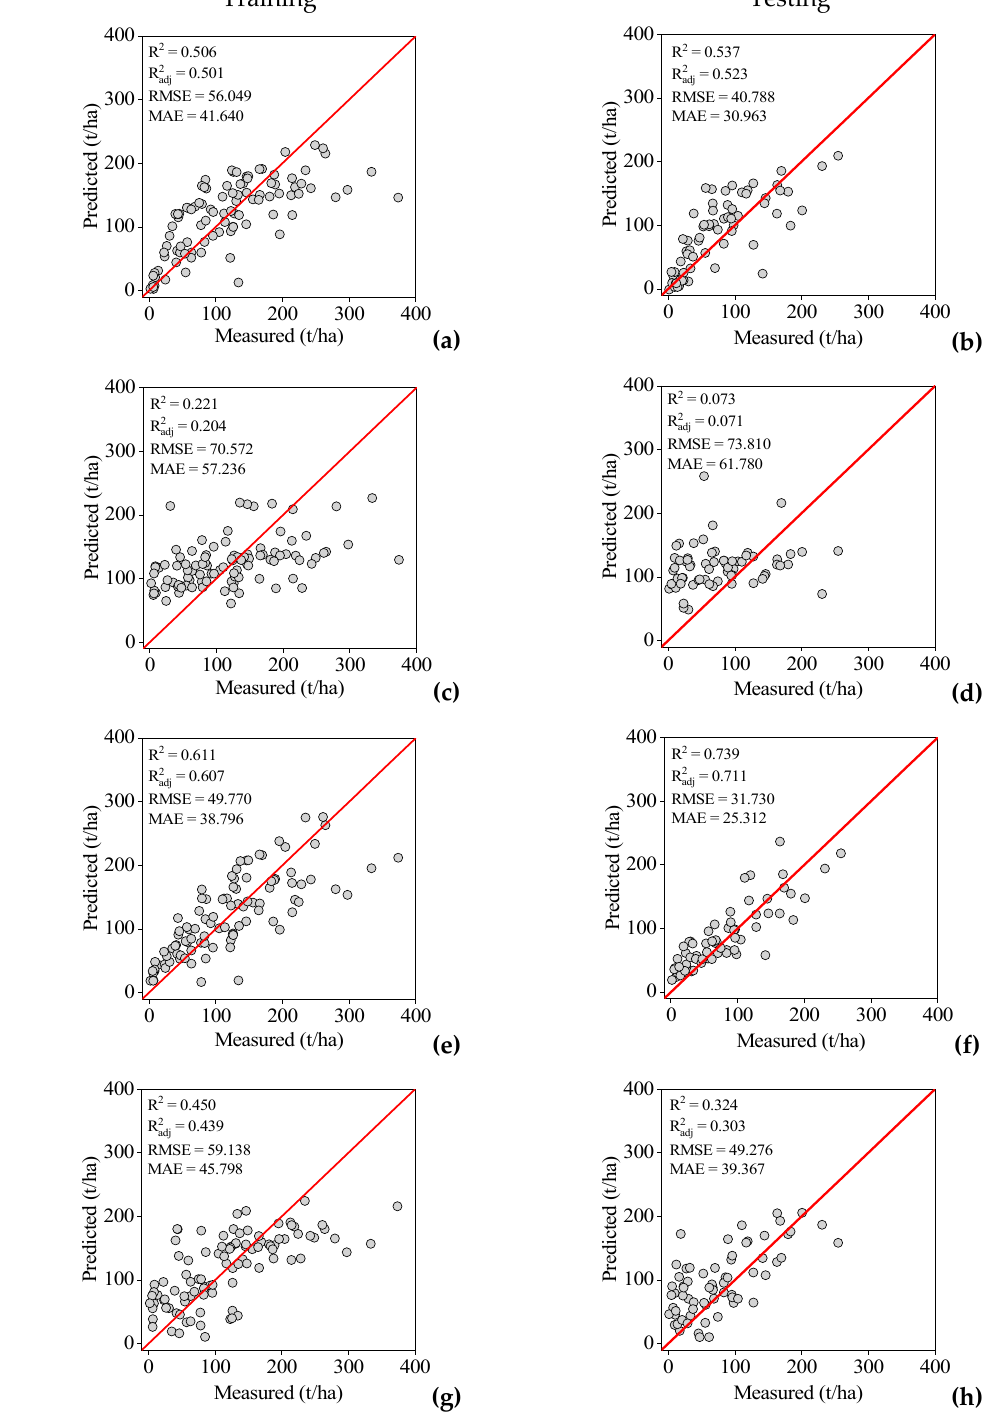
Figure 7. Scatterplot between measured and predicted AGB from the stepwise linear regression of each type of variables. ( a ) Training dataset of height metrics; ( b ) Testing dataset of height metrics; ( c ) Training dataset of intensity metrics; ( d ) Testing dataset of intensity metrics; ( e ) Training dataset of alpha-shape metrics; ( f ) Testing dataset of alpha-shape metrics; ( g ) Training dataset of stand metrics; ( h ) Testing dataset of stand